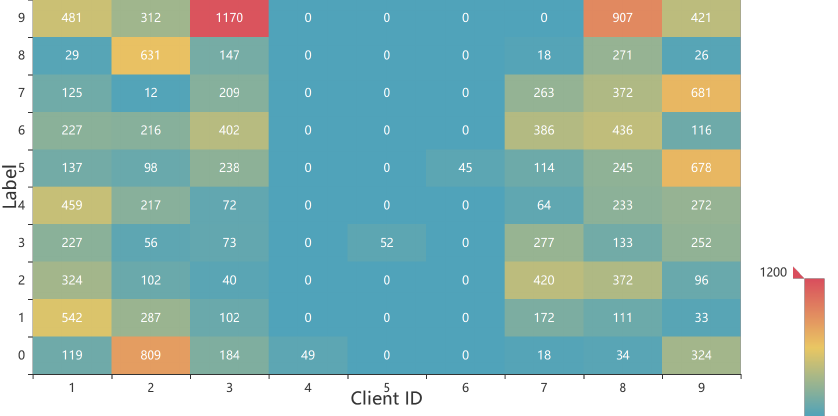
Figure 3. Data distribution of some clients. ID 1 ∼ 3 are positive clients, ID 4 ∼ 6 are negative clients, and ID 7 ∼ 9 are malicious